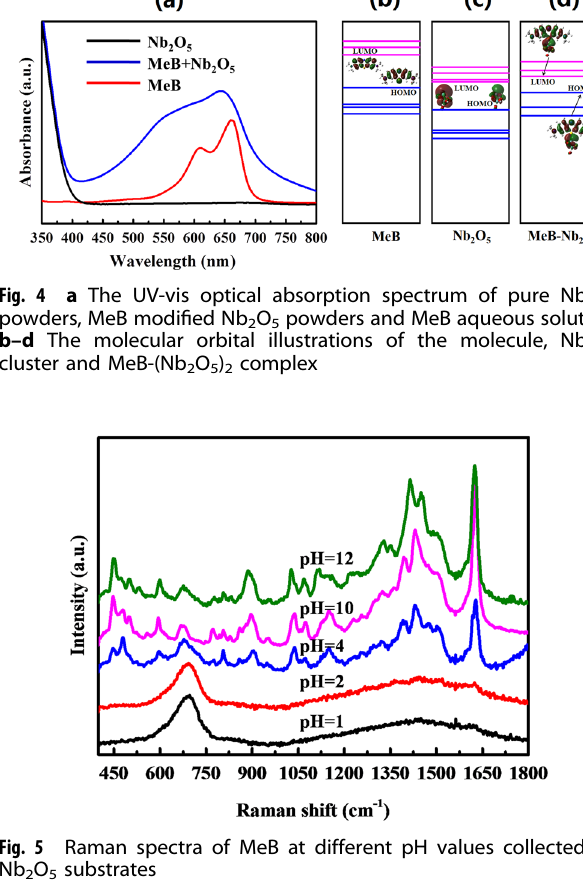
Fig. 5 Raman spectra of MeB at different pH values collected on Nb 2 O 5 substrates